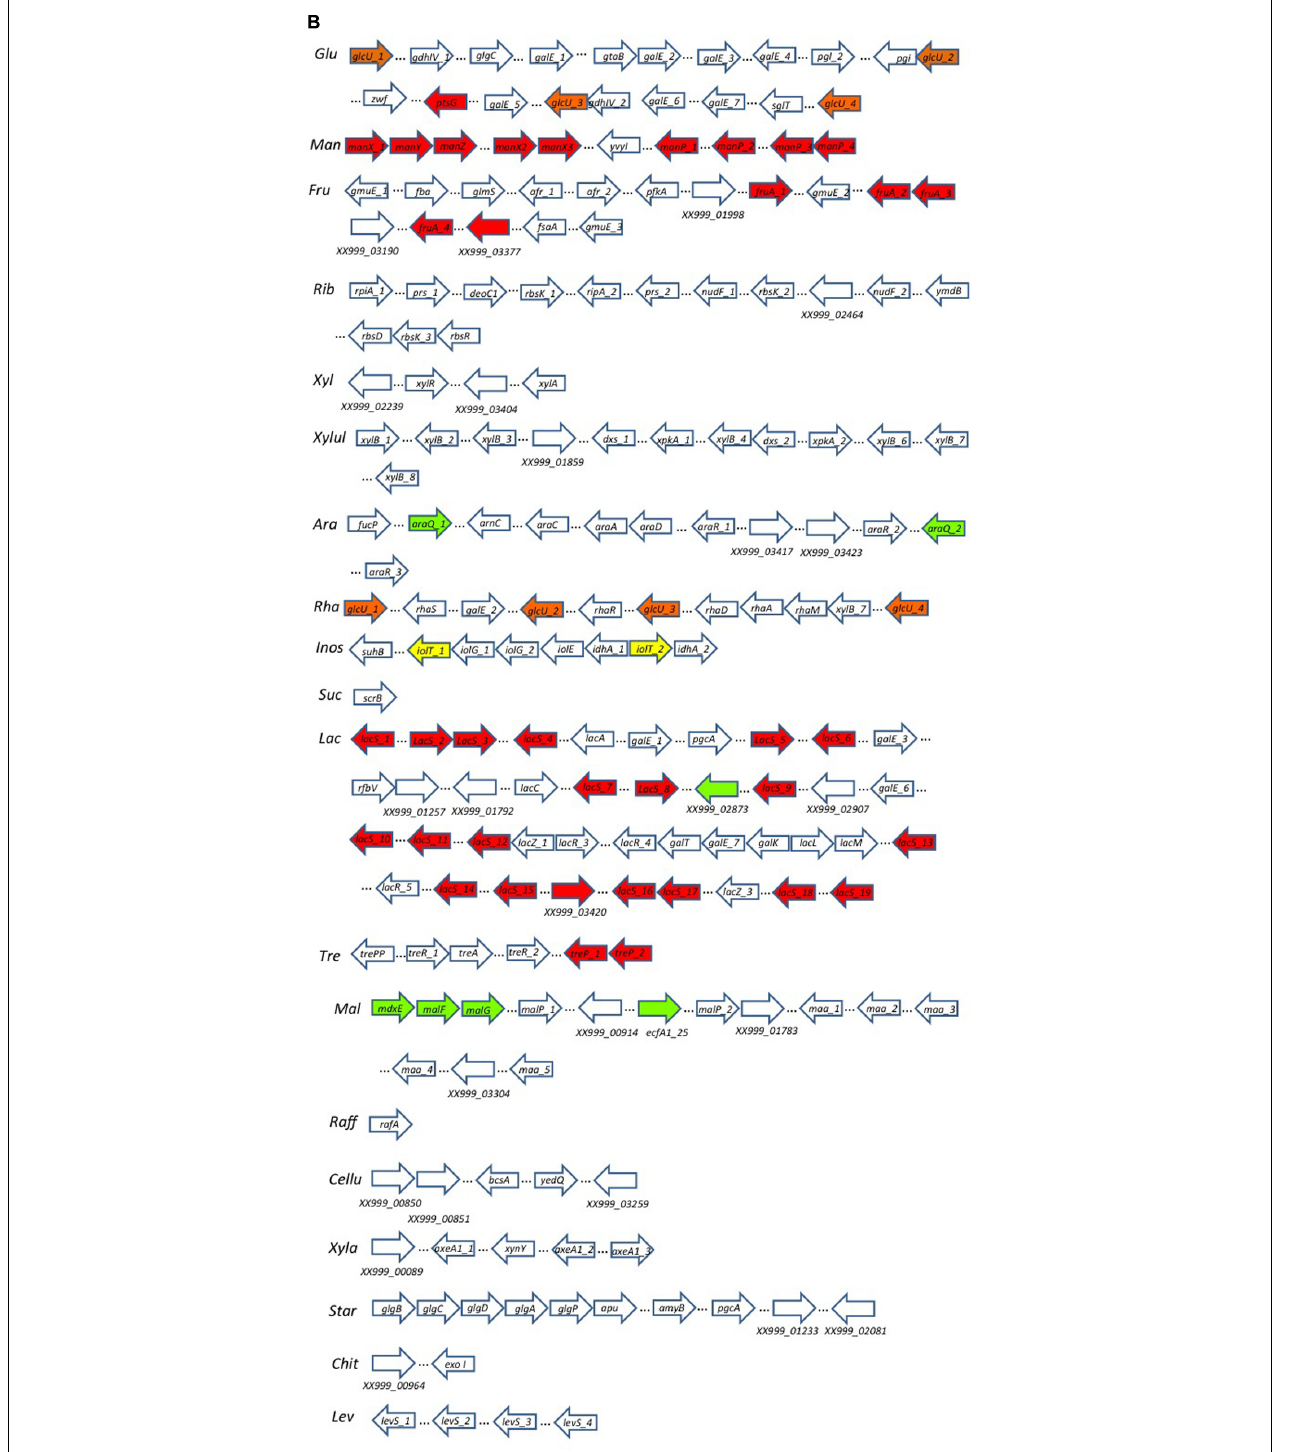
FIGURE 2 | Organization of gene clusters encoding proteins predicted to be involved in carbohydrate utilization as prebiotics by L. pentosus MP-10. (A) Pathway reconstruction as predicted by genome annotation: PTS (phosphotransferase system), red; MFS (Major Facilitator Superfamily), yellow; ABC Transporter, green; GRP (Glucose/Ribose Porter Family), orange. (B) Genetic loci of interest: Ara , arabinose; Cellu , cellulose; Chit , chitin; Fru , fructose; Glu , glucose; Inos , inositol; Lac , lactose–galactose loci; Lev , levan; Mal , maltose; Man , mannose; Raff , raffinose; Rha , rhamnose; Rib , ribose; Star , starch; Suc , sucrose; Tre , trehalose; Xyl , xylose; Xyla , xylan; Xylul , xylulose.